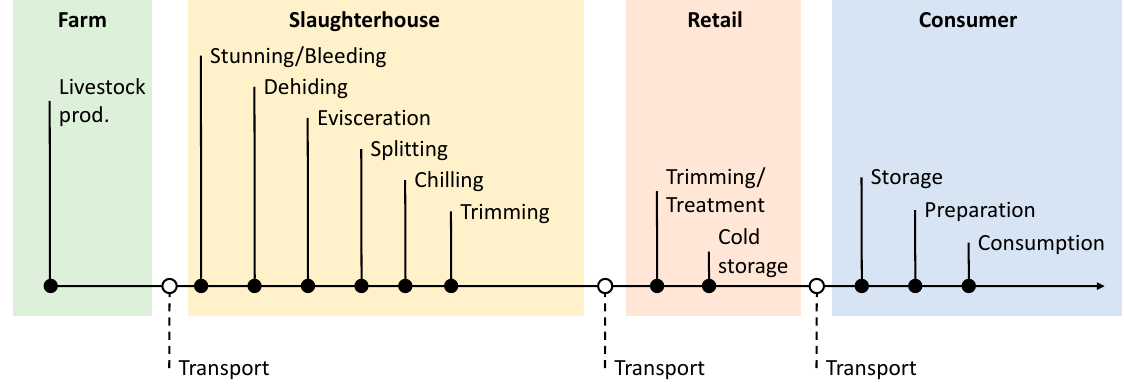
Figure 3. Farm-to-fork chain for beef meat as commonly considered by QMRA studies.